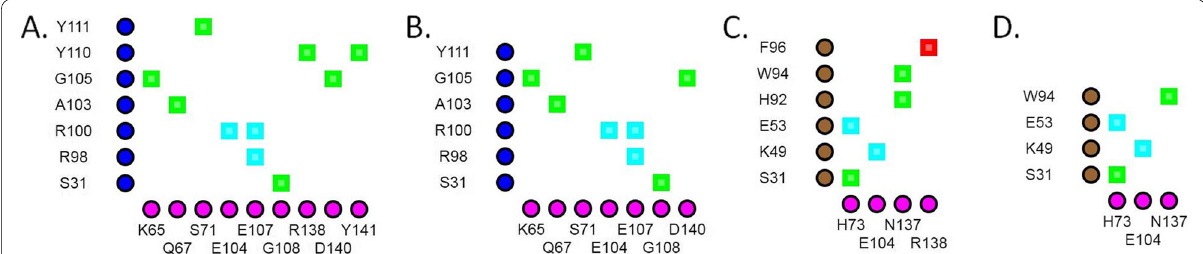
Fig. 5 Interactions of TNFA with golimumab and infliximab. 2D plots of interactions between TNFA and the heavy chain of golimumab in the wild-type ( A ) and TNFA Y141S variant ( B ) structures. 2D plots of interactions between TNFA and the light chain of infliximab in the wild-type ( C ) and TNFA R138W variant ( D ) structures. TNFA residues are shown along the horizontal axis and antibody residues are delineated along the vertical axis. Green- hydrogen bonds; cyan- salt bridges/ionic interactions; and red- cation-pi interactions